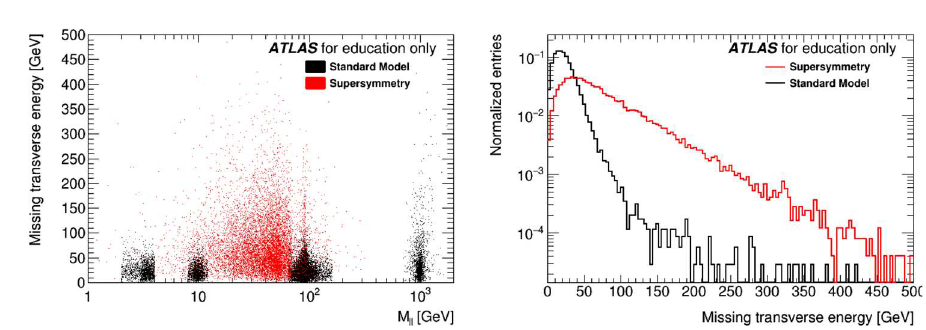
Figure 4 - Distributions of di-lepton invariant mass and missing transverse energy: ATLAS data for education and corresponding SM and Beyond SM Monte Carlo